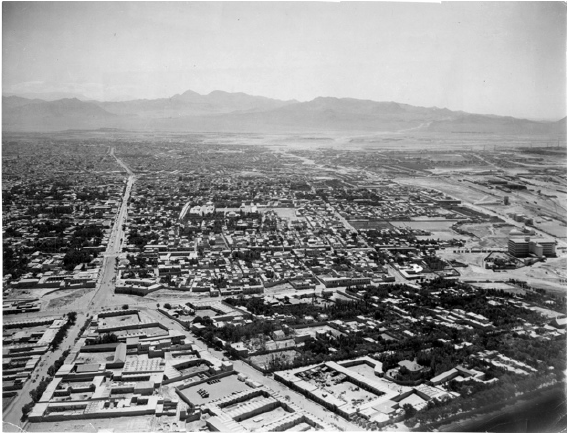
Figure 1. Arial view of Tehran, eastern border of the city, 1942. Source: author’s personal